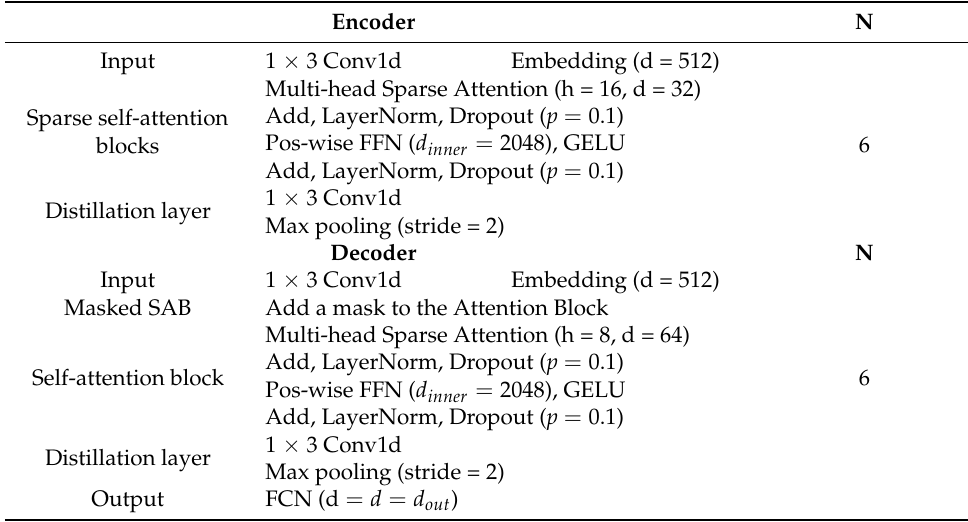
Table 2. Improved structure of sparse self-attentive